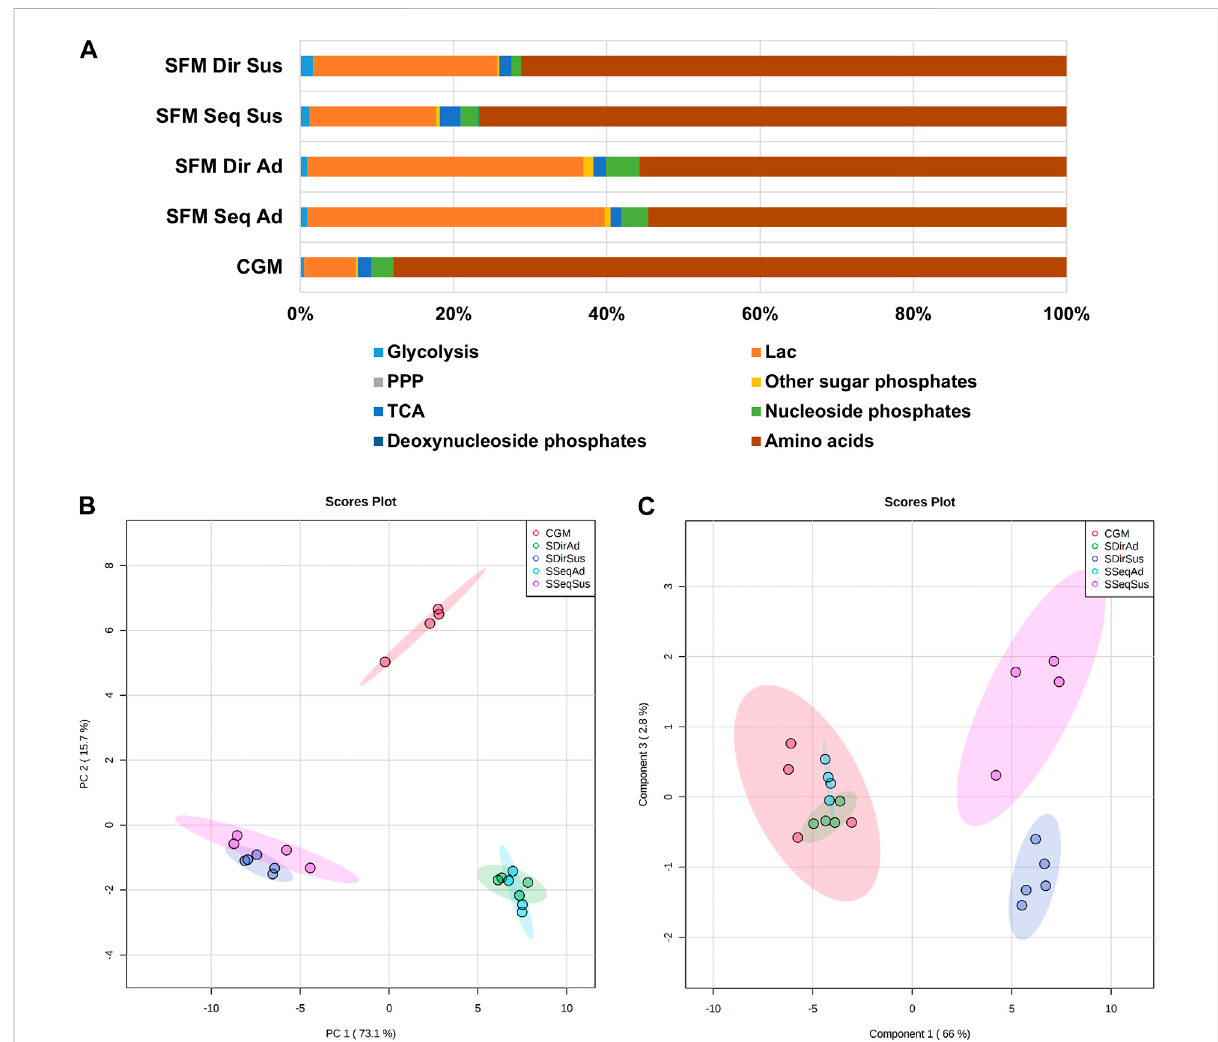
FIGURE 5 The overview of intracellular metabolite pro fi les in 5 different culture systems. (A) The contribution (%) of metabolic classes to the total measuredintracellularmetabolites. (B) 2DscoreplotofPrincipalComponentAnalysis(PCA)and (C) PartialLeastSquares-DiscriminantAnalysis(PLS- DA) with total 61 metabolites in 5 different culture systems. The coloredellipses represent the 95% con fi dence interval of the sample grouping. After log transformation and autoscale normalization, multivariate statistical analysis was performed in MetaboAnalyst. (CGM; control growth medium culture; red-circles , SSeqAd; Serum-free medium sequential adapted adherent culture; light-blue circles, SDirAd: Serum-free medium direct adapted adherent culture; green-circles, SSeqSus; Serum-free medium sequential adapted suspension culture; pink-circles, SDirSus; Serum- free medium direct adapted suspension culture;